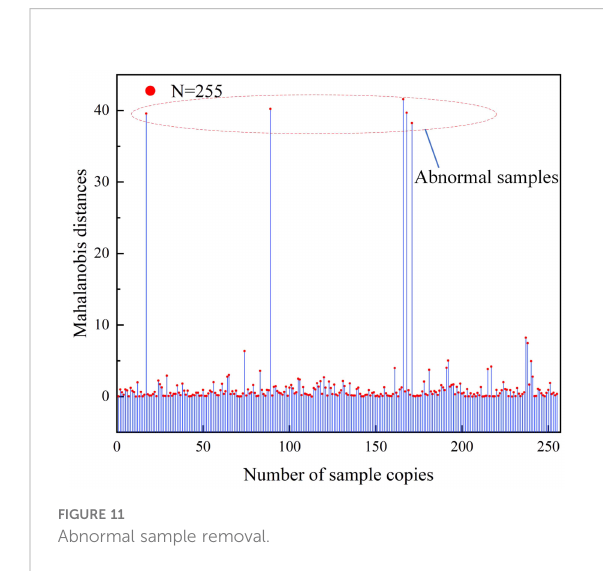
FIGURE 11 Abnormal sample removal.